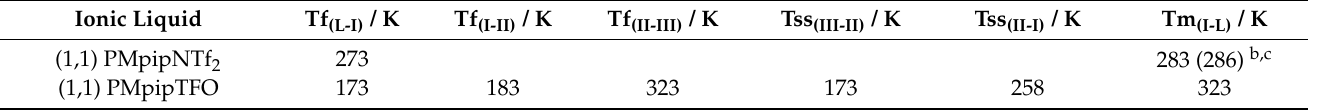
Table 1. Results of the thermal analysis for the pure ionic liquids and comparison with the literature a . Ionic Liquid Tf (L-I) / K Tf (I-II) / K Tf (II-III) / K Tss (III-II) / K Tss (II-I) / K Tm (I-L) / K (1,1) PMpipNTf 2 273 283 (286) b,c (1,1) PMpipTFO 173 183 323 173 258